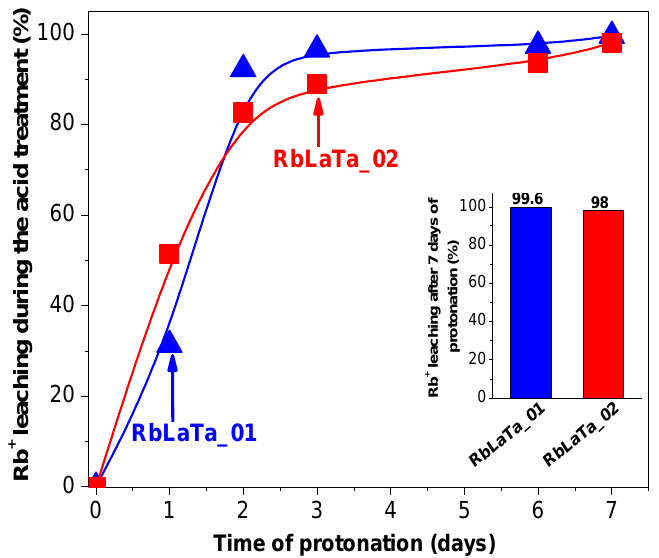
Figure 5. Time course of Rb + leaching after acid treatment of RbLaTa_01(02) samples.